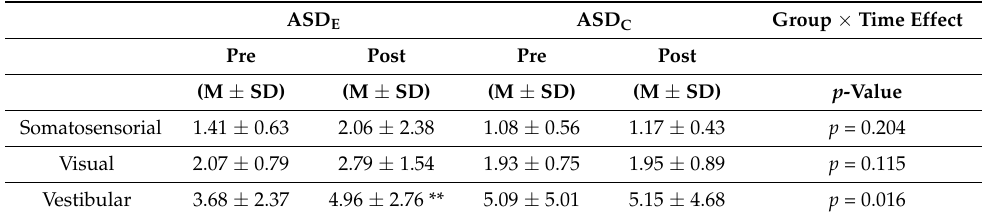
Table 2. Comparison of afferent inputs and group × time effect.